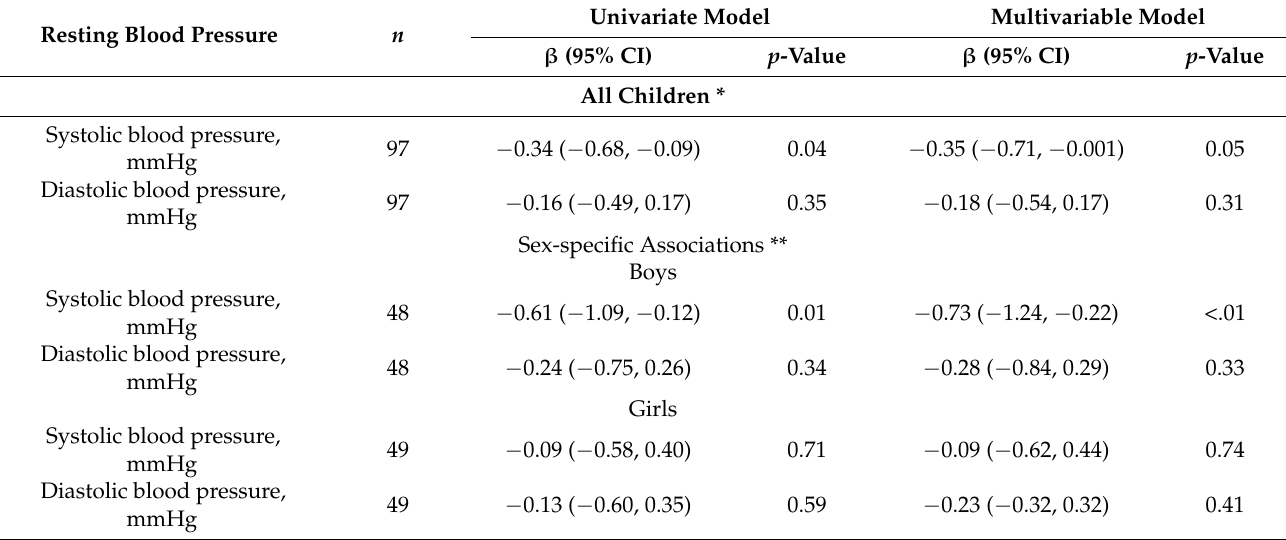
Table 3. Change in age four resting blood pressure per 10% increase in cord blood mononuclear cell relative telomere length for all children and by sex: linear regression ( n =